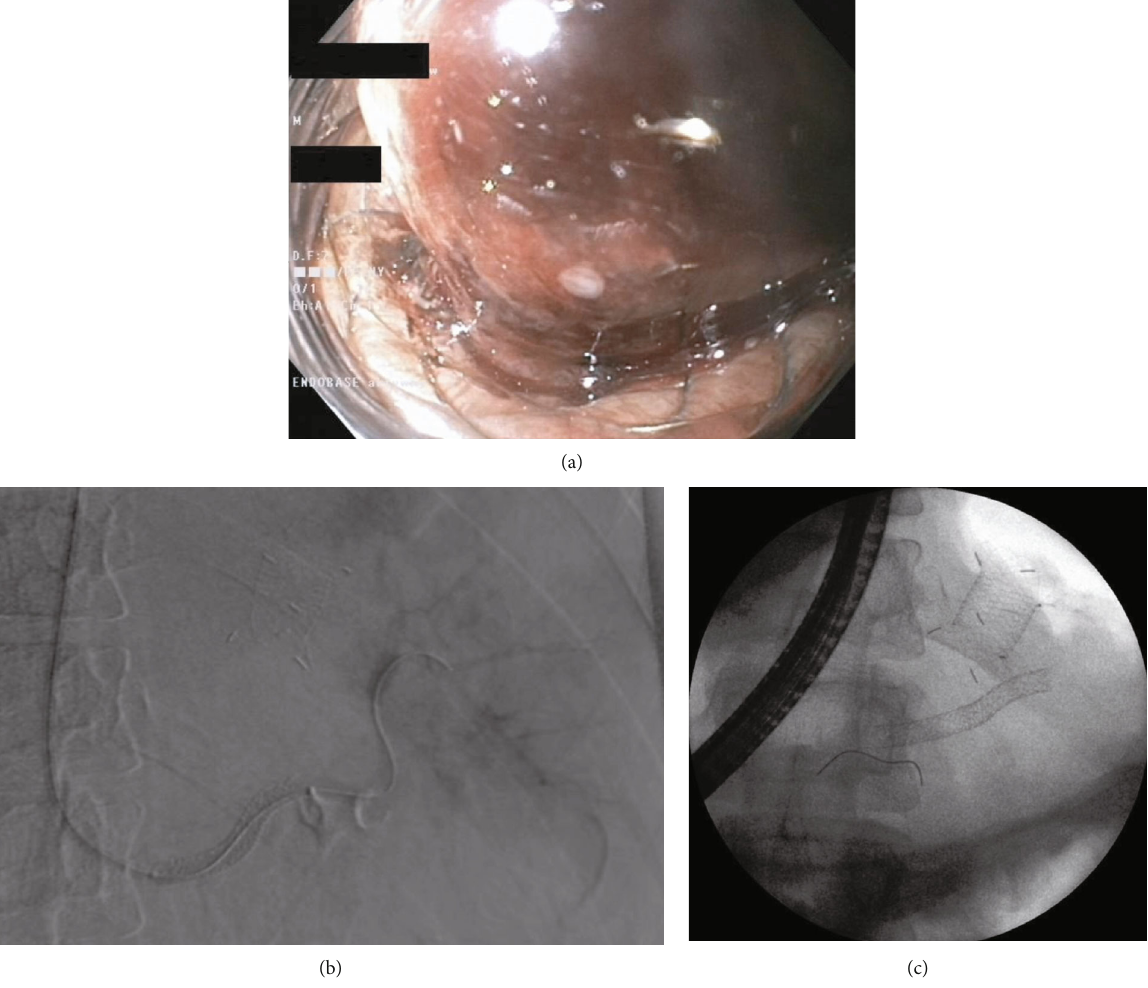
Figure 12: (a – c) Bleeding from the splenic artery during transmural drainage of a pancreatic necrosis. (a) The endoscopic image reveals a blood clot inside of the transmural stent. (b, c) The patient received endovascular treatment by inserting a stent graft to bypass the damaged